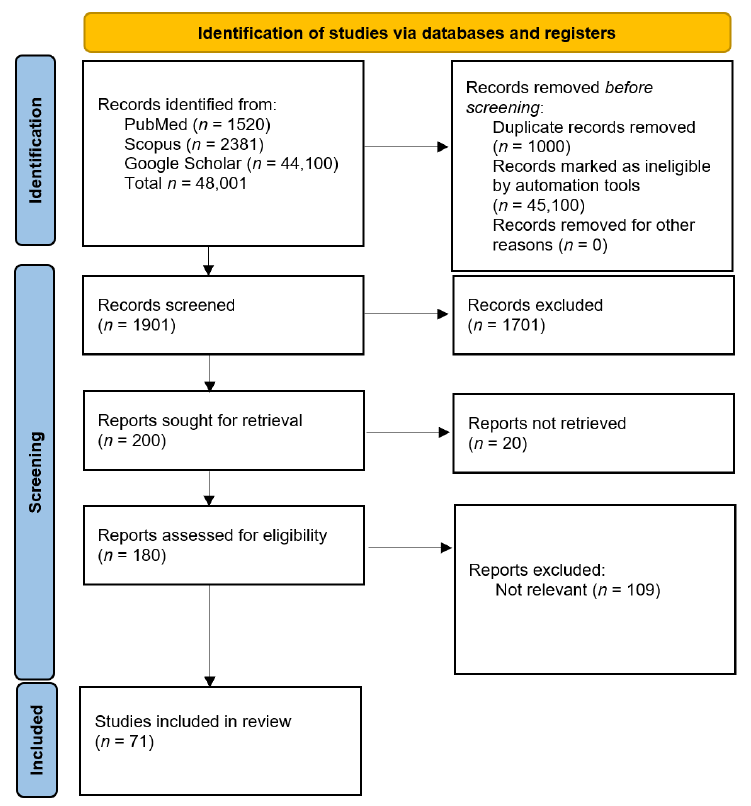
Figure 1. Studies selection.